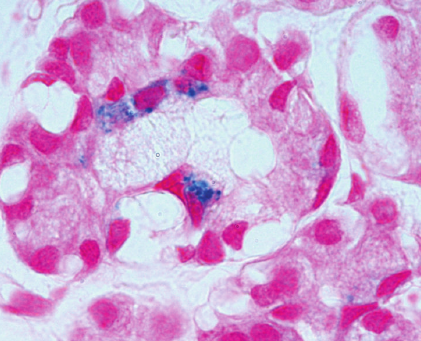
Figure 1: Granules of stainable iron (haemosiderin) within cyto- plasm of epithelium of minor glands of the mucosa of the lower lip. Perls’ technique with nuclear fast red counterstain, original magni- fication 1,000x.